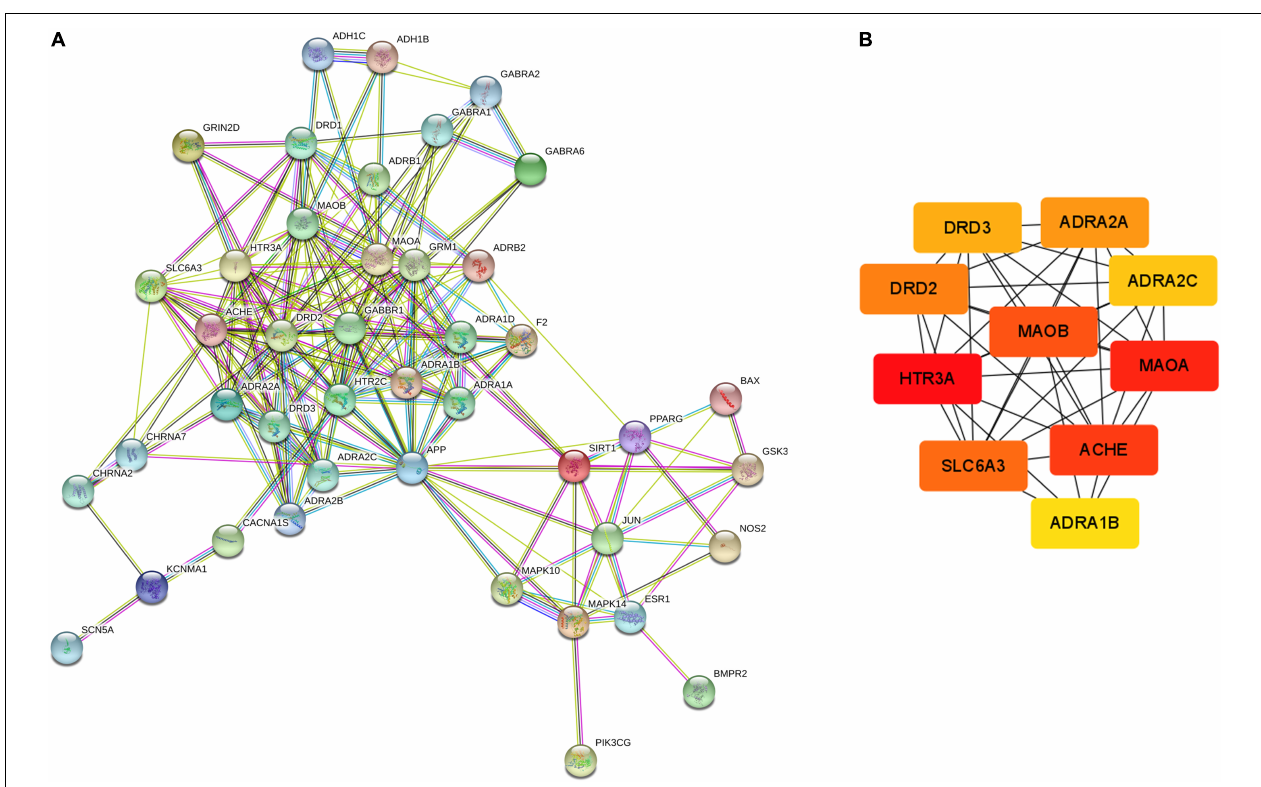
FIGURE 4 | Protein-protein interaction (PPI) network and Hub gene screening map of targets. (A) PPI network exported from STRING database. (B) Key subnetwork of top 10 nodes analysed by CytoHubba.